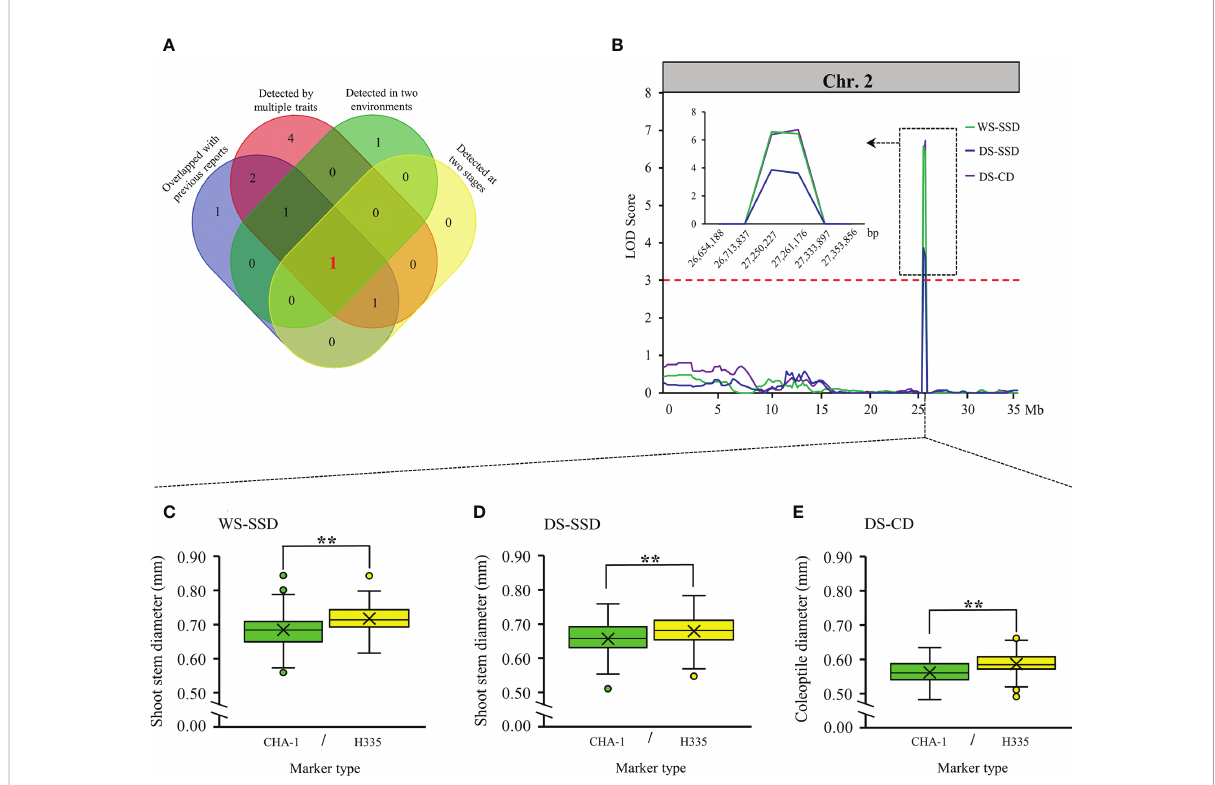
FIGURE 4 Validation of reliable loci. (A) Venn diagrams showing unique and shared criteria for QTLs detected in our study. (B) locus 3 located on chromosome 2 identi fi ed by linkage analysis. The box shows a magni fi cation of the QTL candidate interval region on chromosome 2. (C-E) Boxplots showing the distribution of phenotypic differences between the two alleles of locus 3. Differences between the genotypes were analyzed using Student ’ s t-test, ** represents signi fi cance at the 0.01